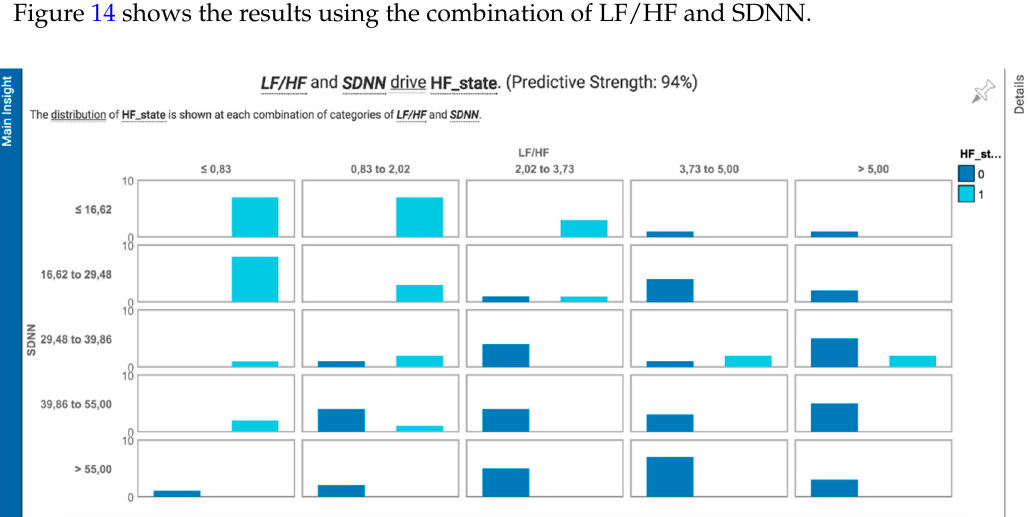
Figure 14. Results for Short Term HRV, using LF/HF + SDNN as multiple predictors.